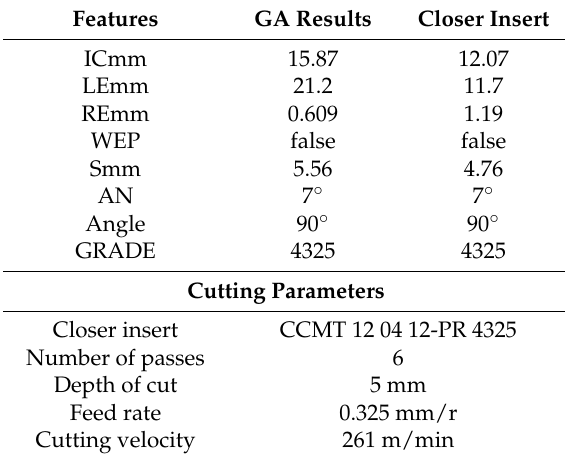
Table 13. Results of the heavy roughing operation example.